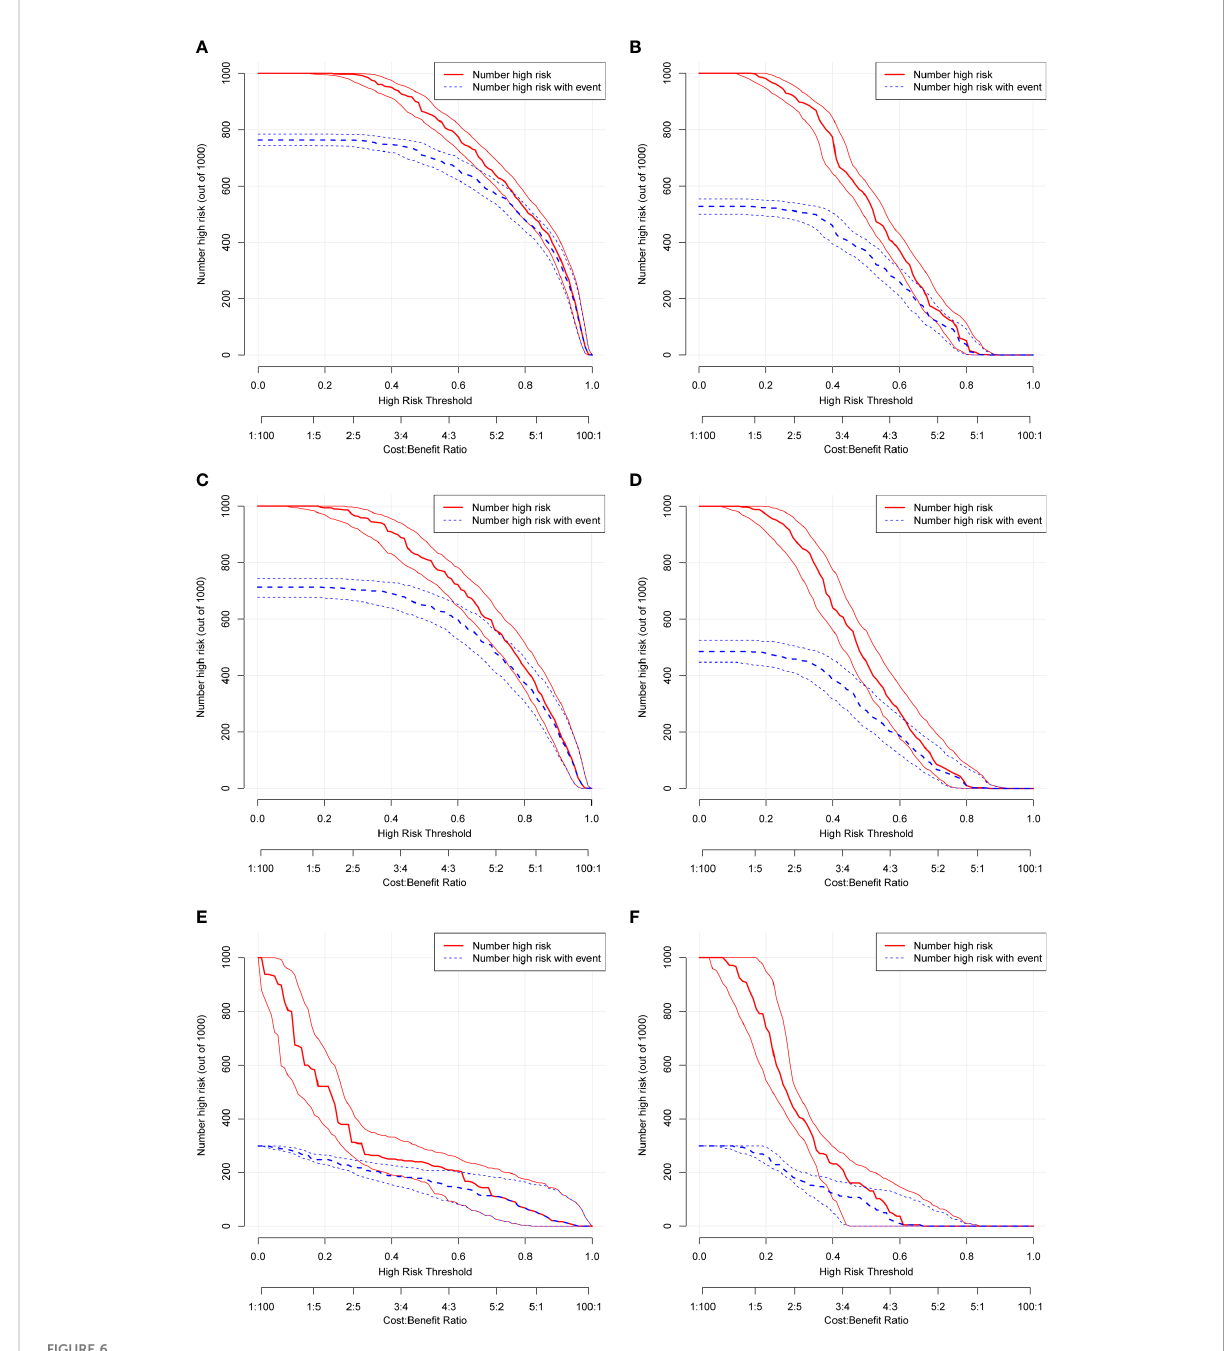
FIGURE 6 Clinical impact curve (CIC) based on nomograms. (A) CIC of OS for patients in the training set. (B) CIC of CSS for patients in the training set. (C) CIC of OS for patients in the validation set. (D) CIC of CSS for patients in the validation set. (E) CIC of OS for patients in the external validation set. (F) CIC of CSS for patients in the external validation